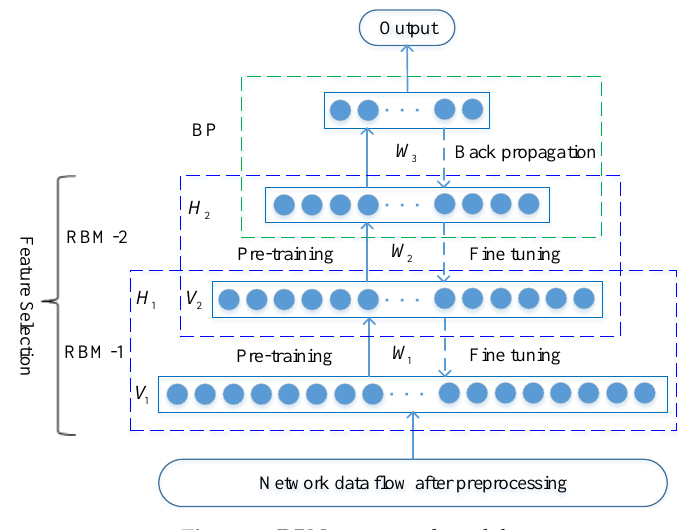
Figure 3. DBNs structural model.